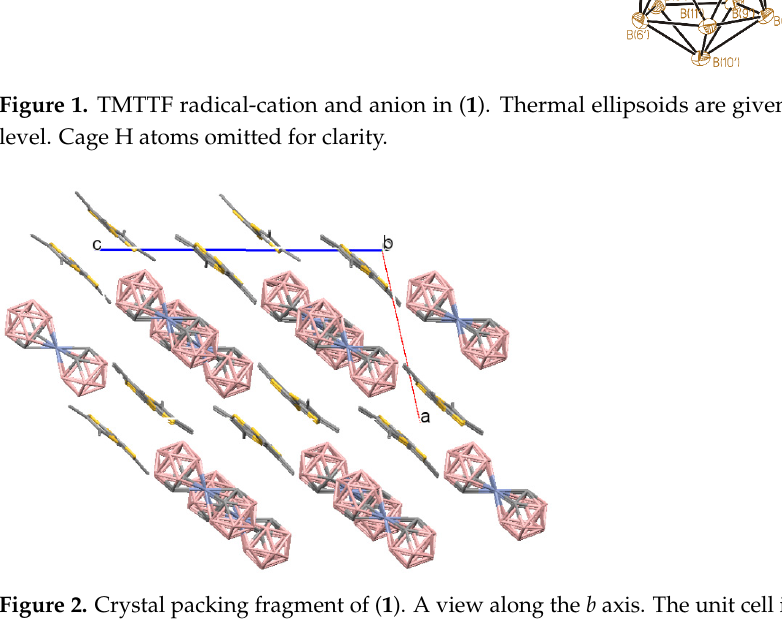
Figure 3. Anion in ( 2 ). Thermal ellipsoids are given at 30% probability level. Cage H atoms omitted for clarity.